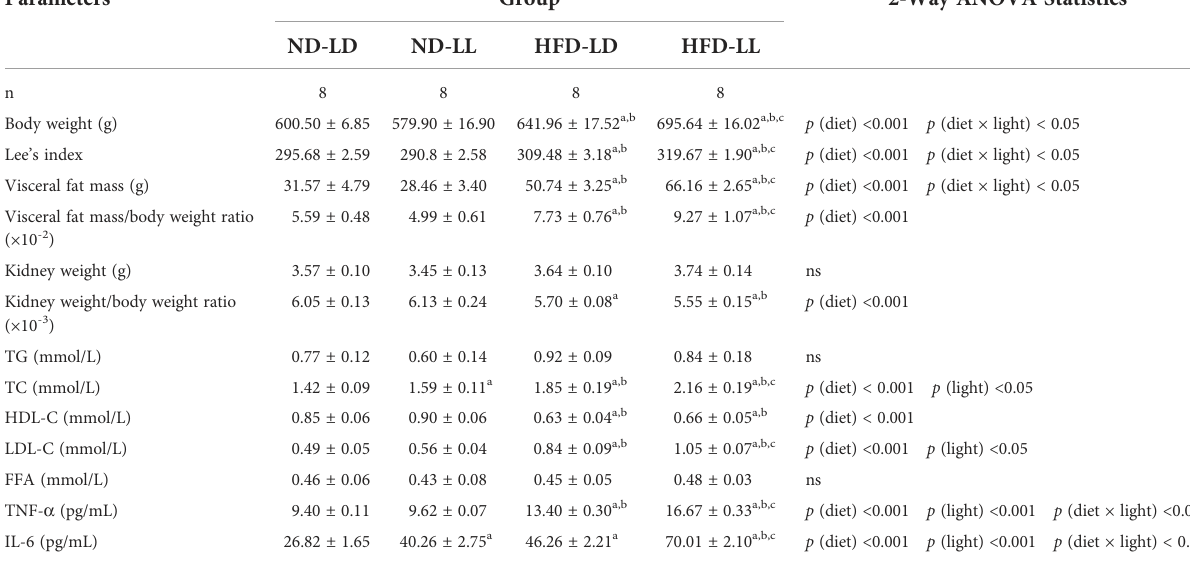
TABLE 1 Characteristics of rats in each group at the end of experiment. Parameters